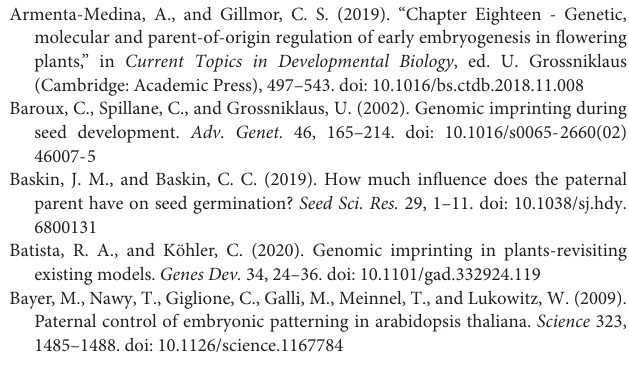
Supplementary Figure 1 | Illustration of the crossing scheme used and schematic diagram of the ploidy level of the different F1 seed compartments from inter-ploidy (unbalanced) crosses. Chromosomes of the tetraploid L er -0 tester line (genotype LLLL) are represented in black, while those of Copac-1, DraIV 6-13, Lago-1, IP-Vdt-0, Baa-1 and IP-Smt-1 (genotype AA) are shown in gray. Supplementary Figure 2 | Correlation between the parent-of-origin effects of the 71 accessions on F1 hybrid seed size when crossed with the tester Line Ler-0, and the genetic distance between these accessions and the reference accession L er -0. The red line shows the regression of parent-of-origin effects onto the genetic distance, to which the R 2 value and p-value correspond. Supplementary Figure 3 | Seed size (mm 2 ) of paternal-excess F1 hybrid triploids using 48 genetically different maternal genotypes that are part of the accession panel used in this study. The horizontal red dashed line represents the mean seed size value for the L er -0 F1 isogenic triploid control (0.1682 mm 2 ). Error bars represent SD, N > 20 seeds/genotype. Supplementary Table 1 | List of Arabidopsis thaliana natural diploid accessions used in this study and their geolocation. Supplementary Table 2 | Calculations of Best-Parent (%BPH), Mid-Parent (%MPH) and Worst-Parent Heterosis (%WPH) for F1 hybrid diploid seed size. Values that do not follow the observed trend are highlighted in red. Supplementary Table 3 | MPH levels of reciprocal balanced (2x X 2x) and inter-ploidy hybrid crosses (2x X 4x, 4x X 2x). 2xA (diploid accession), 2xL (2x L er -0), 4xL (4x L er -0). N/A, not available due to triploid block. Supplementary Table 4 | Deviations from the mid-parent value (MPV) in F1 hybrid diploids and triploids. Data represents the mean F1 seed size. Asterisks represent significant differences between the F1 hybrids and the MPV (‘ ∗∗∗∗ ’ and ‘ ∗ ’ indicate statistical significance at p- value < 0.0001 and p- value < 0.05, respectively, determined by Student’s t -test. Ns , not significant). N/A, not available due to triploid block. Supplementary Table 5 | MPH levels across 48 genetically different F1 hybrids at the diploid and paternal-excess triploid level. 2xA (diploid accession), 2xL (2x L er -0), 4xL (4x L er -0). Supplementary Table 6 | Influence of geolocation on phenotypic variation. Pearson correlation coefficient (r) was used to determine the latitudinal and longitudinal association of the 71 genetically different accessions of this study with reciprocal F1 hybrid diploid seed size, seed size of selfed isogenic diploid parental lines and parent-of-origin effects. Correlation is significant at the 0.05 level. Supplementary Table 7 | Broad-sense heritability of hybrid F1 seed size in terms of the parent of